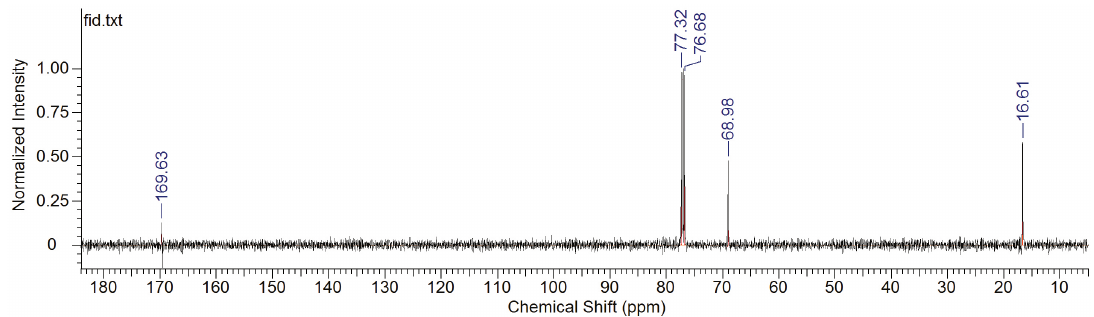
Figure 5. 13 C-NMR PDLLA spectrum.